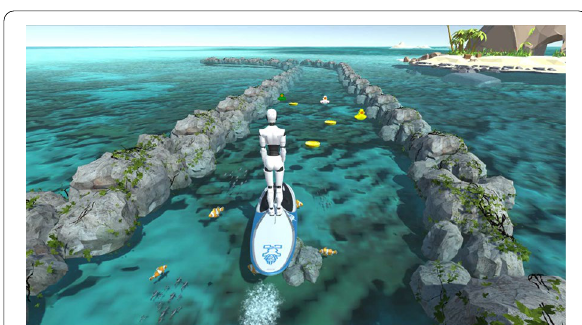
Figure 7 Virtual training scene